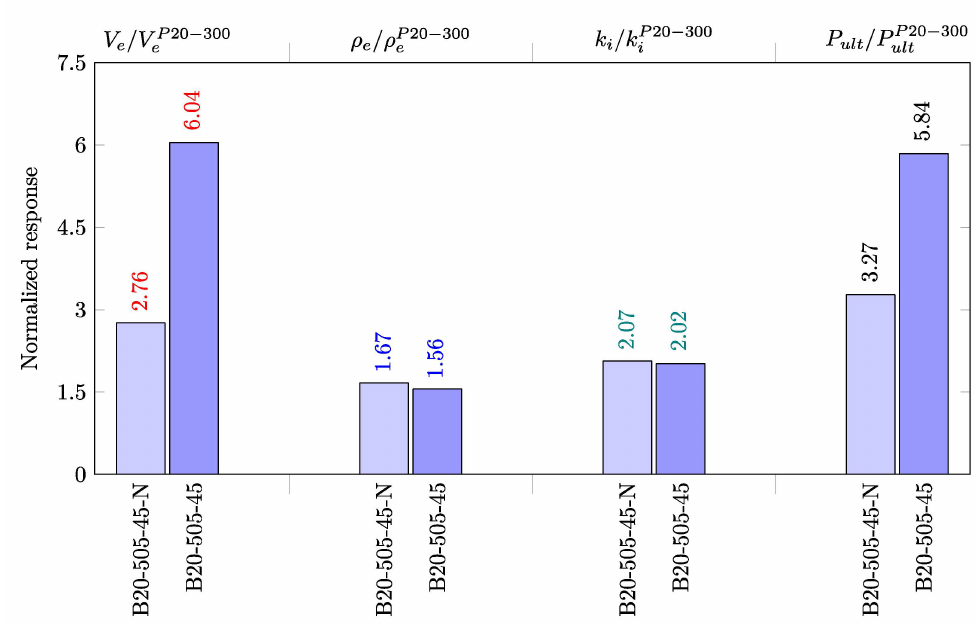
Figure 8. Effect of material yield strength on the shear response of the tested beams (the exact values are provided at the top of each bar).